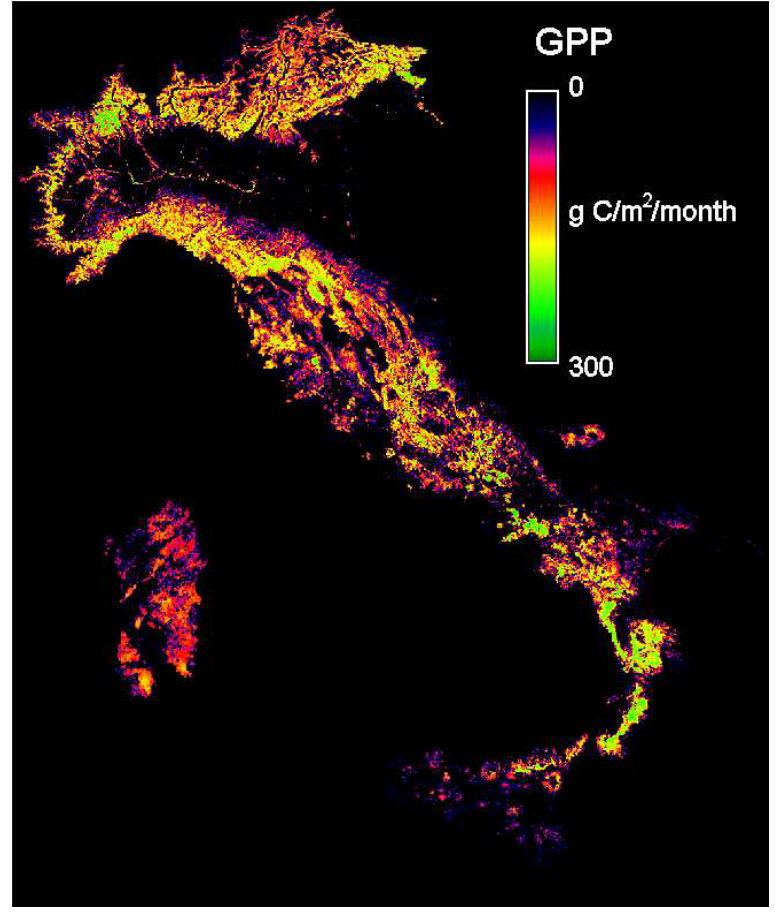
Figure 2. Monthly GPP image of August 2003 obtained by the application of Modified C-Fix (see text for